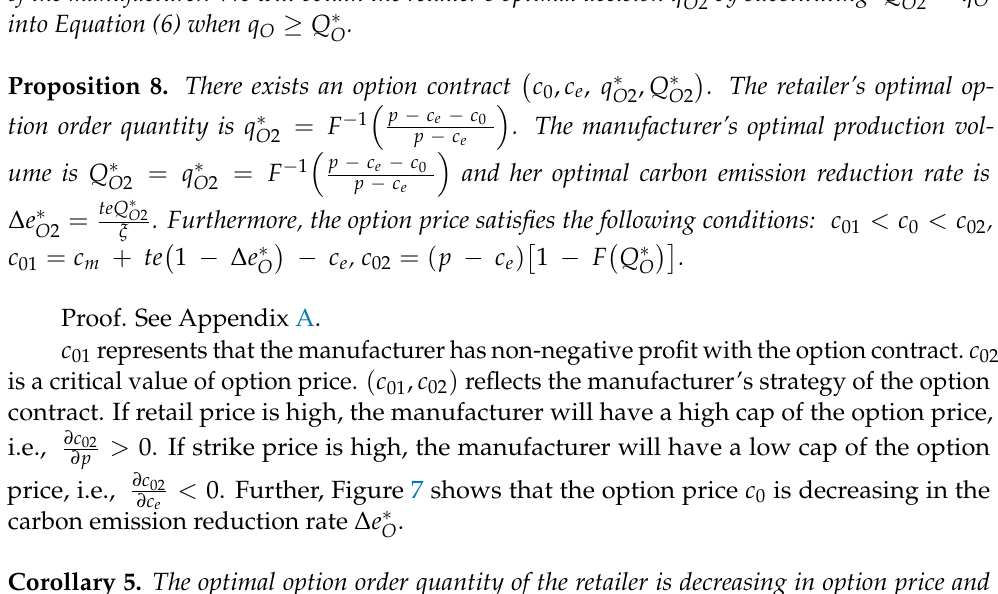
Table 4. Risk-sharing of partners under the option contract